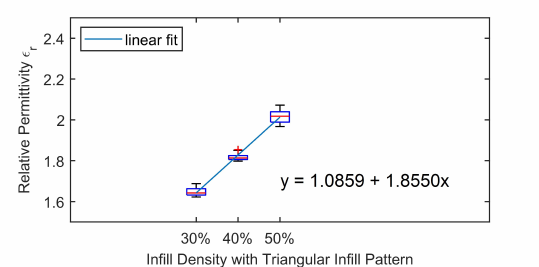
Figure 9. Relative permittivity box figures of triangular infill pattern.